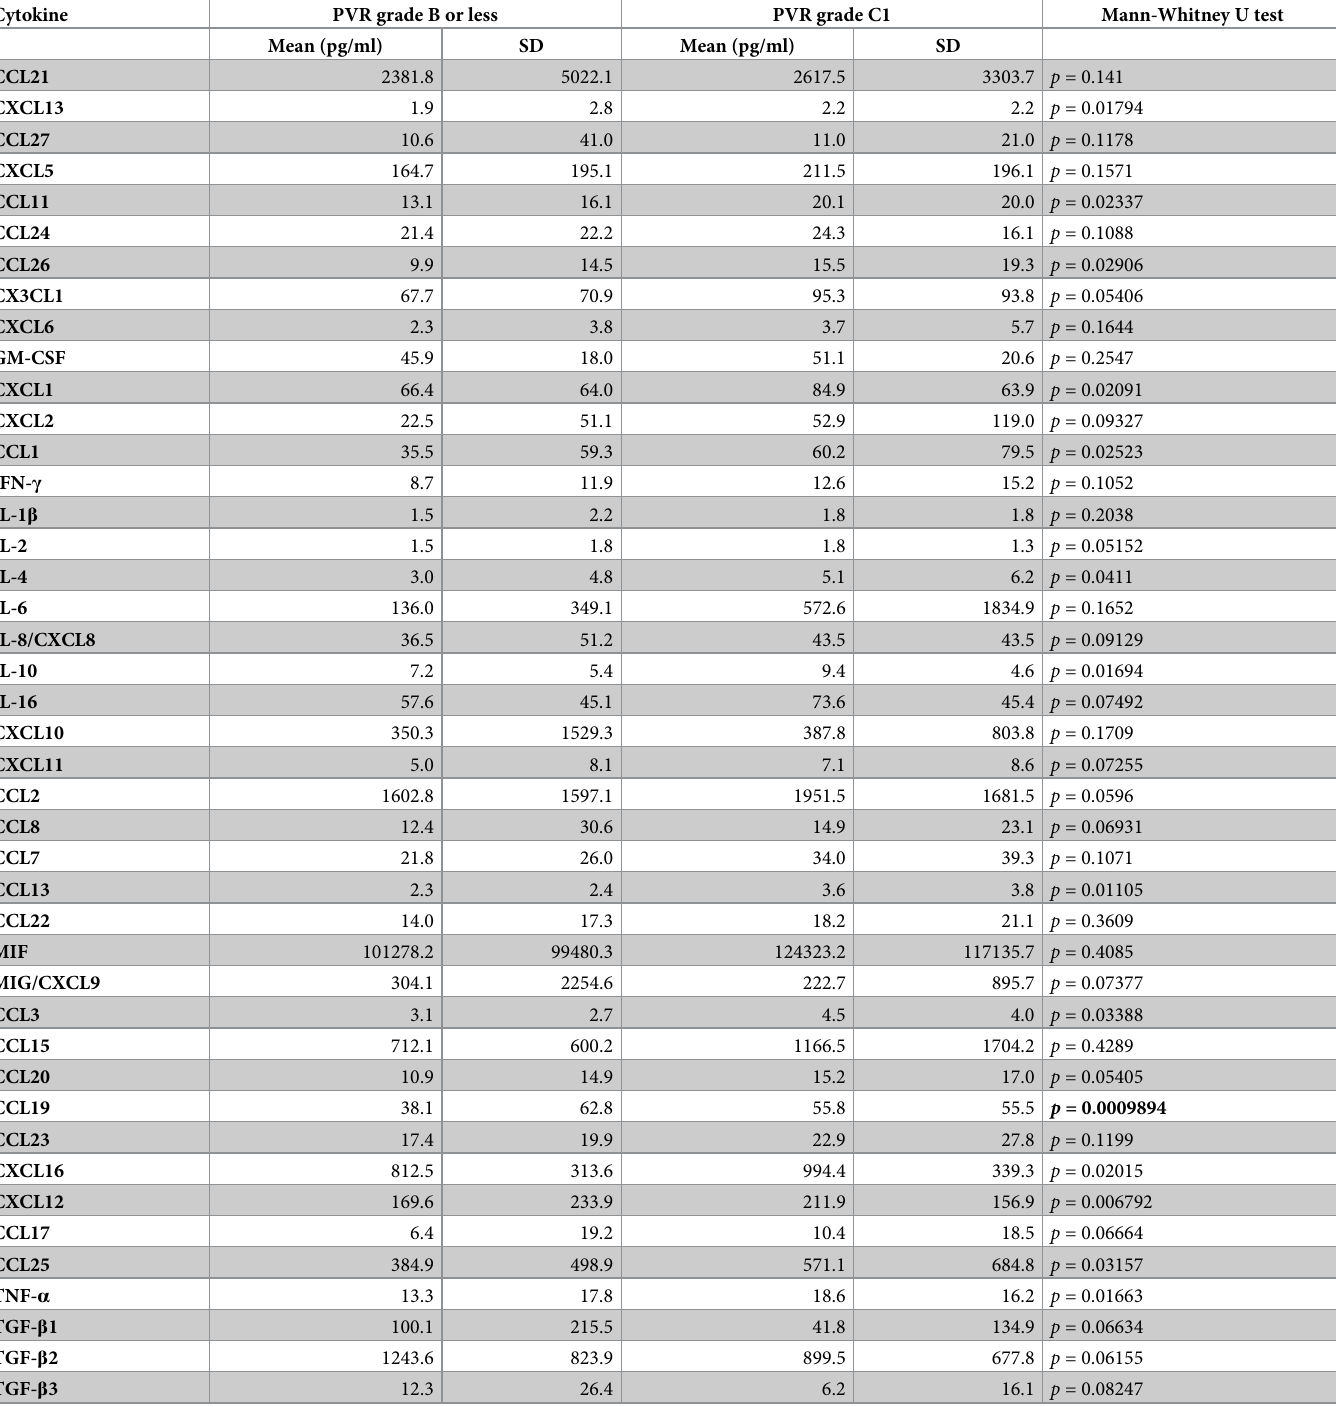
Table 4. Mean concentrations (pg/ml) and standard deviations (SD) of cytokines in the vitreous of eyes with primary retinal detachment with PVR grade B or less and in eyes with PVR C1.